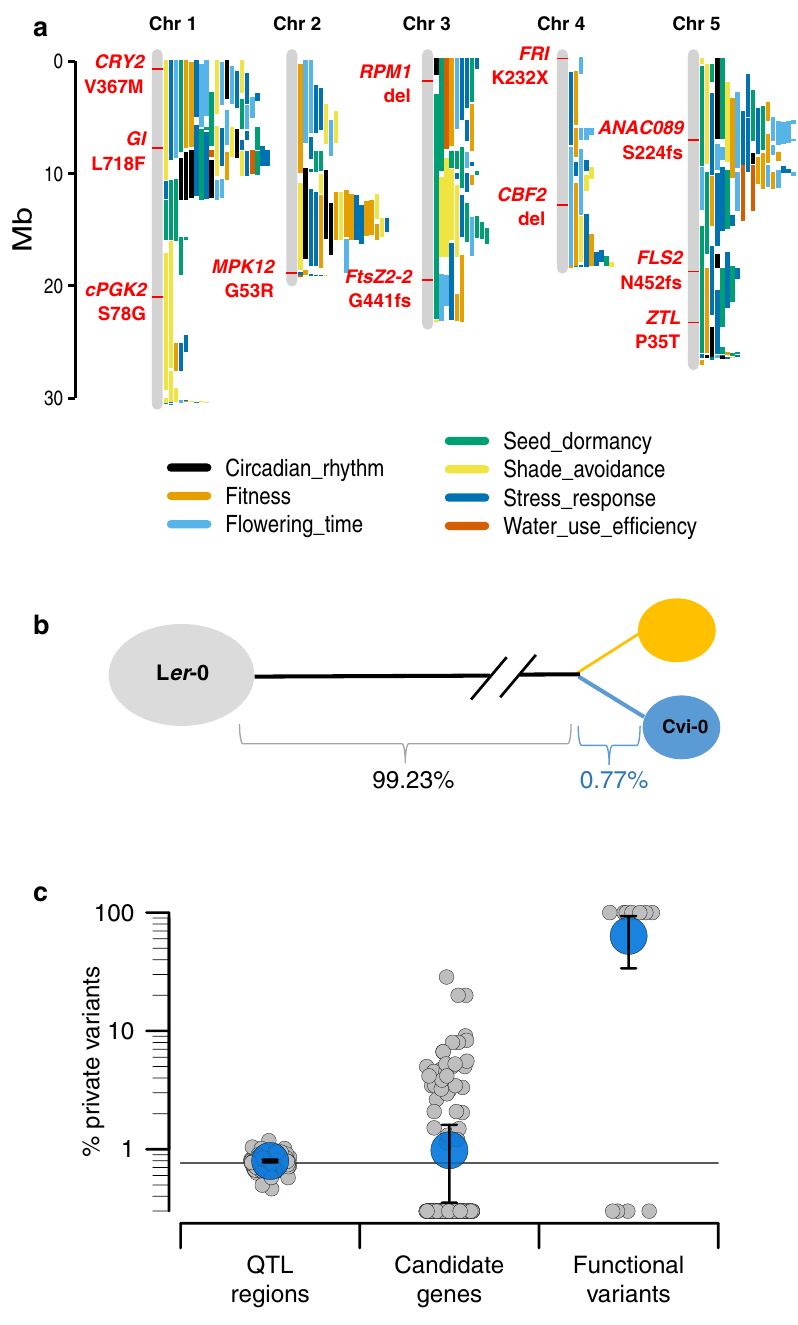
Fig. 6 Evidence of multivariate selection from 129 QTL mapping analyses using Cvi-0. a Representative subset of previously identi fi ed QTL in Cvi-0 x L er -0 RILs, with validated functional variants in red. Each segment along the chromosomes represents one QTL region with colours representing phenotypic classes. b Schematic of the relationship between the RILs parents, with branch lengths proportional to the percentage of genome-wide variation fi xed in CVI and segregating in Santo Antão. c Percentage of variation private to Santo Antão in QTL regions ( n = 121), candidate genes ( n = 142) and functional variants ( n = 11). Horizontal line shows the genome-wide average. Each grey dot represents a single QTL, candidate gene or functional variant, blue dots represent the average, and error bars represent the 95% CI. Source data are provided as a Source Data fi